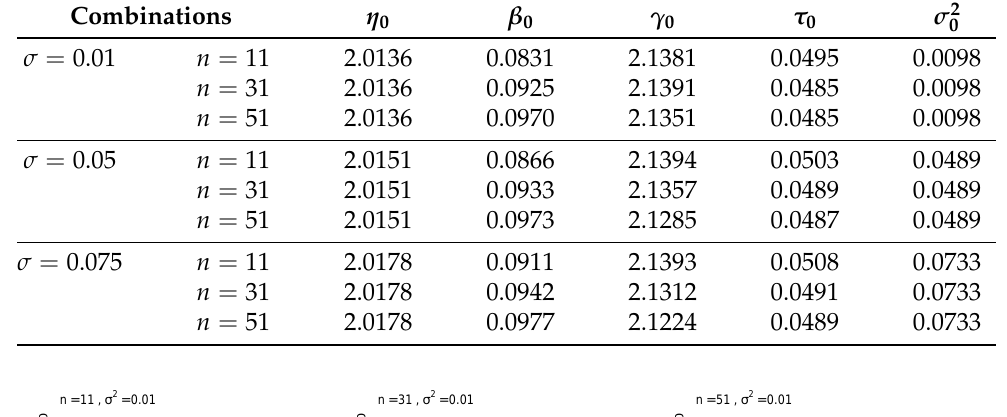
Table 6. Initial solutions for simulated data of the H 3 process.